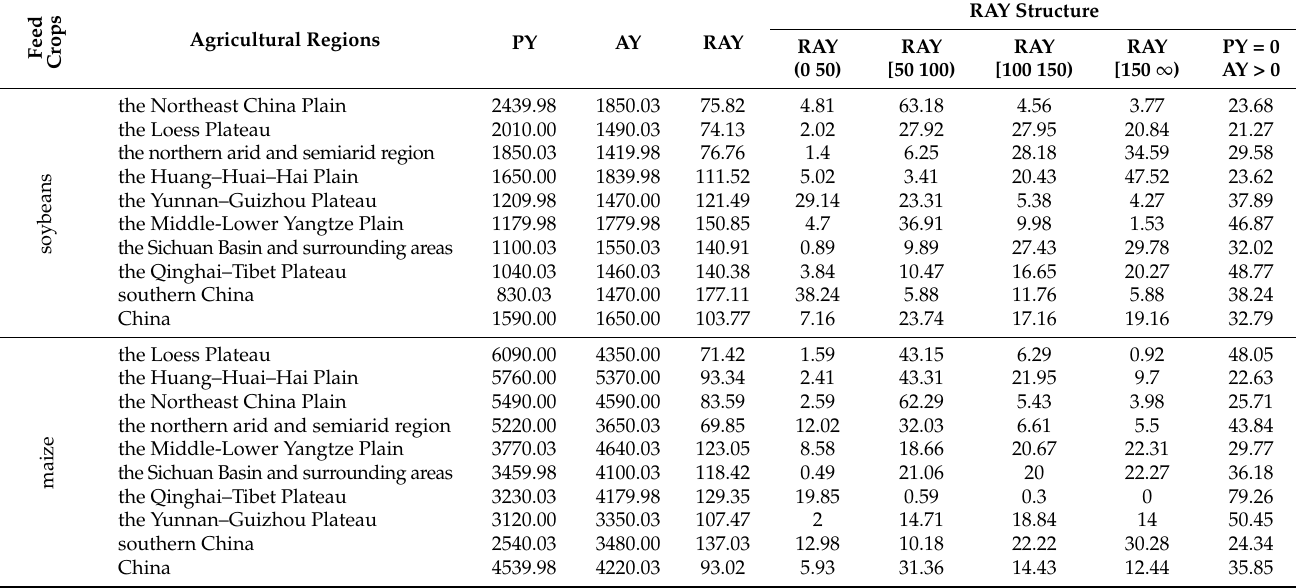
Table 3. The AY/PY and YPDC structure of soybeans and maize in China (kg · hm − 2 ,